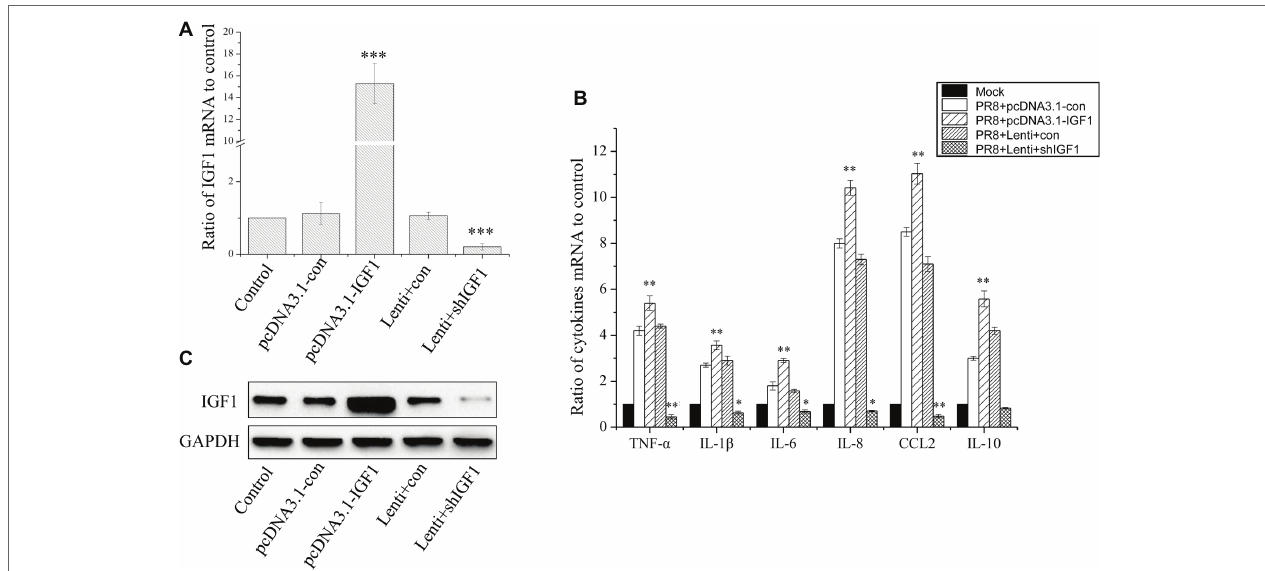
FIGURE 2 | IGF1 regulates the expression of inflammatory cytokines in response to PR8 infection. (A) Q-PCR detection of IGF1 mRNA overexpression and inhibition in stably transfected A549 cells; (B) Western blot detection of IGF1 overexpression and inhibition in stably transfected A549 cells; GAPDH was used as loading control, and figures were representative of three independent experiments; (C) regulation of the intracellular inflammatory cytokines expression following PR8 infection (MOI = 0.5) after overexpression or inhibition of IGF1. Data were the means ± SD from three independent experiments. * p < 0.05; ** p < 0.01; *** p < 0.001 vs. Mock by t